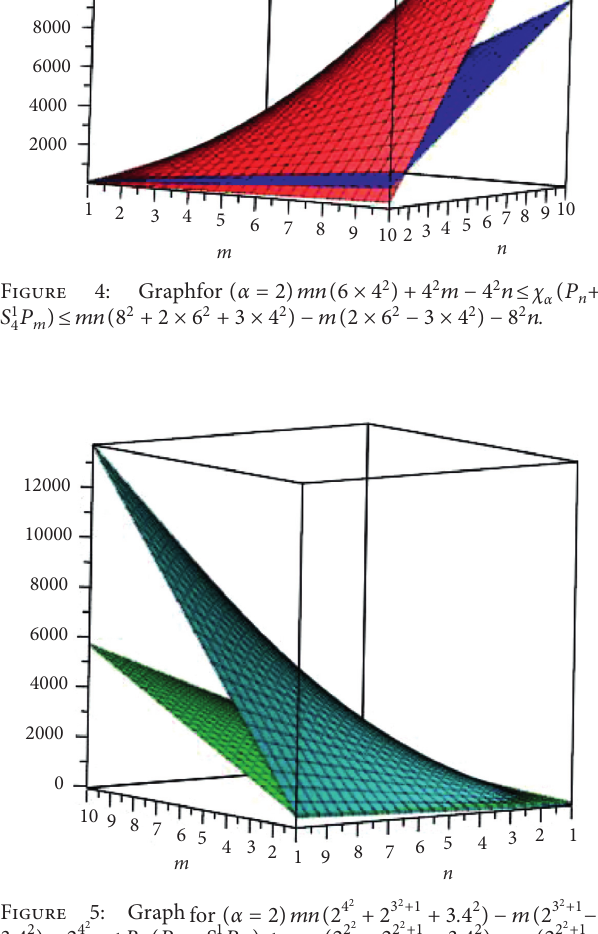
Figure 7: Graph for ( α � 2 ) mn ( 2 . 6 2 2 + 3 2 . 2 2 2 + 1 + 3 . 4 2 )− m ( 6 2 2 +